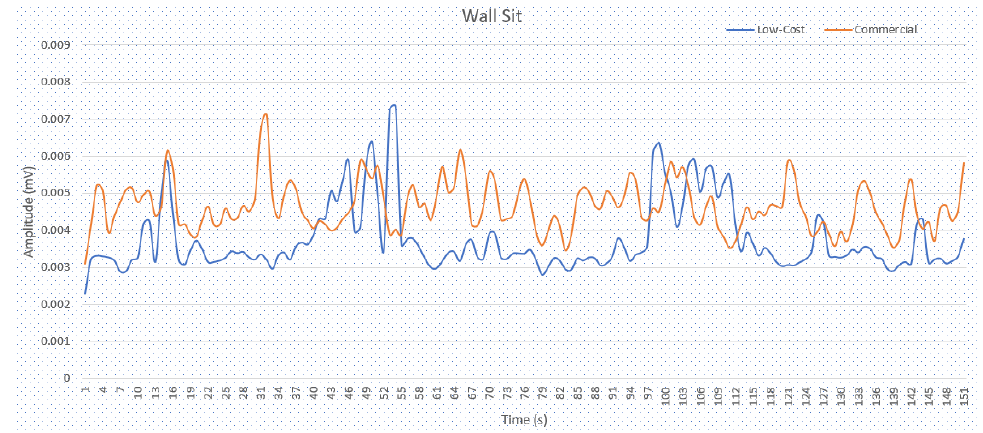
Figure 9. Amplitude graph of wall